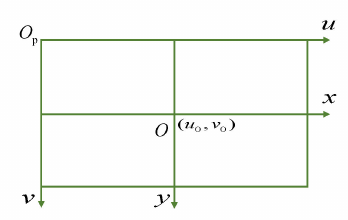
Figure 8. The relationship between image pixel coordinate system and image physical coordinate